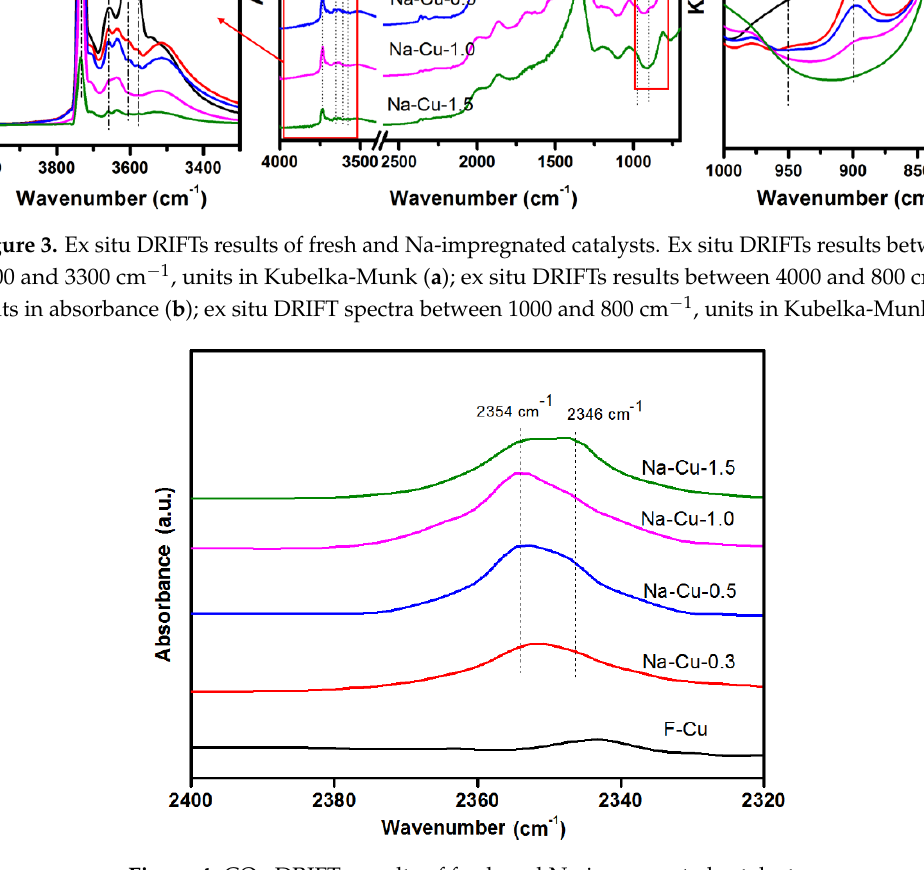
Figure 3. Ex situ DRIFTs results of fresh and Na-impregnated catalysts. Ex situ DRIFTs results between 4000 and 3300 cm −1 , units in Kubelka-Munk ( a ); ex situ DRIFTs results between 4000 and 800 cm −1 , units in absorbance ( b ); ex situ DRIFT spectra between 1000 and 800 cm −1 , units in Kubelka- Munk ( c ).